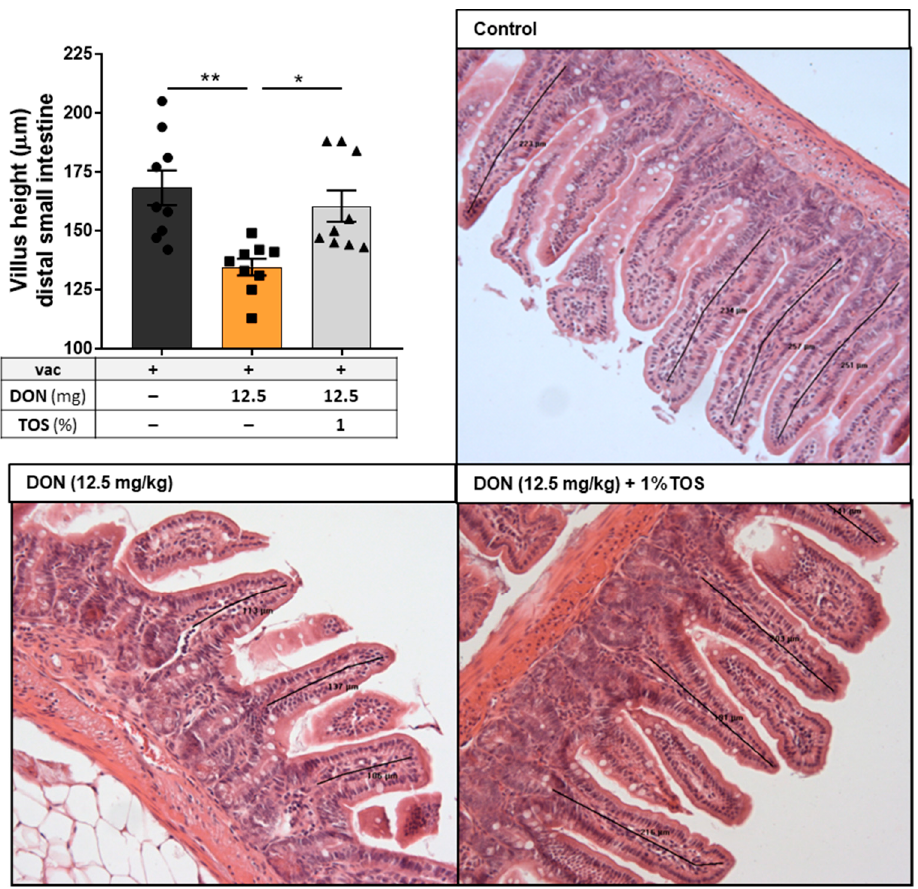
Figure 8. Villus height in ileum sections of the small intestine. Representative photomicrographs of H&E-stained tissue from mice receiving either control or deoxynivalenol (DON, 12.5 mg/kg) ± trans-galacto-oligosaccharides (TOS, 1% wt/wt)-containing diets. Data are presented as mean ± SEM. * p < 0.05 and ** p < 0.01 indicate statistical differences.